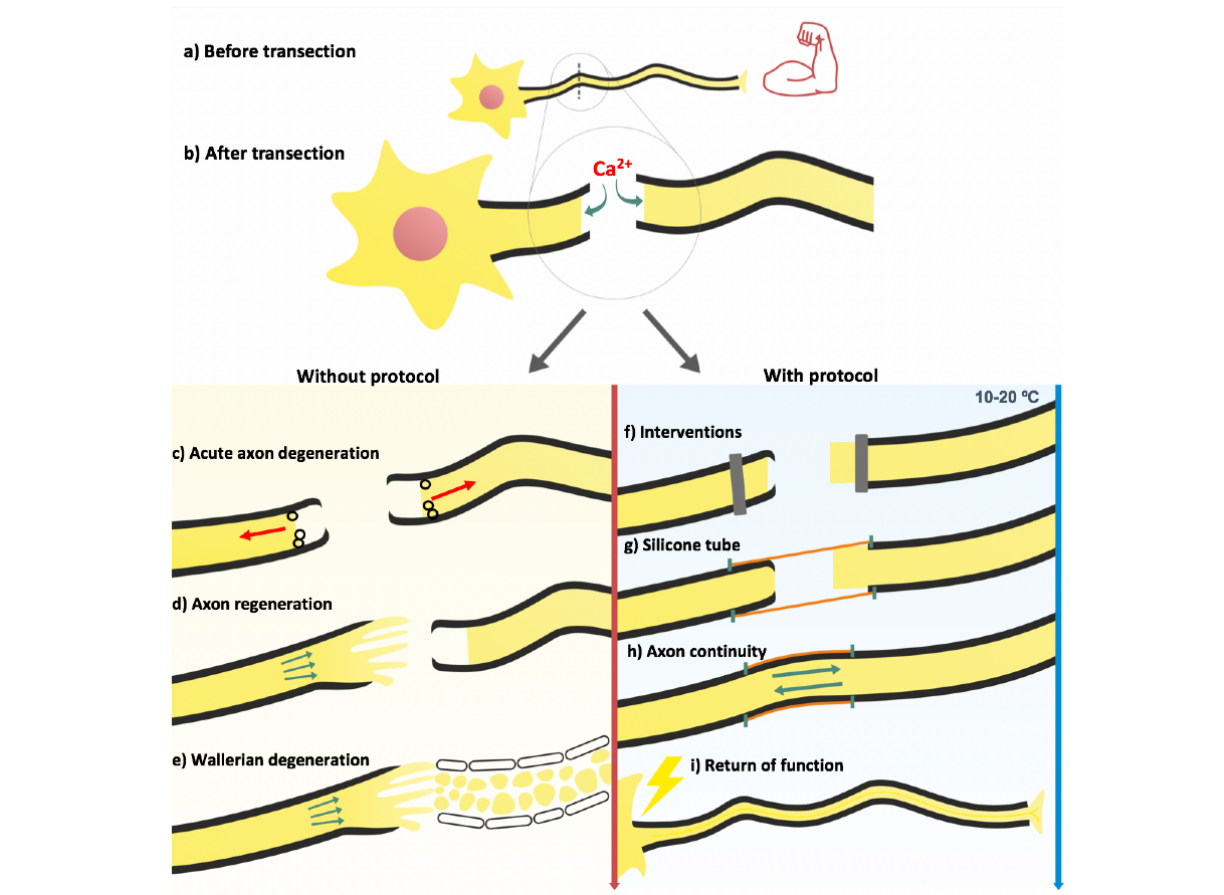
Figure 2. Novel nerve repair protocol. This image compares the usual course of nerve transection (on the left) with the theoretical benefits of the novel nerve repair protocol if fusion occurs (on the right). In (b), note that calcium influx after transection leads to acute axon degeneration, which is noted in (c). Also in (c), membrane seals begin to form (black circles). In (d), axon regeneration begins in the proximal segment. In (e), Wallerian degeneration occurs and regenerating axons regenerate within Schwann cell tubes. In (f), the preoperative interventions have been administered and double approximating clamps (gray vertical lines) are applied to the proximal and distal nerve ends, which will act to seal the axolemmal membranes and prevent further axon degeneration. In (g), the silicone tube is sutured in place after nerve ends have been rinsed with calcium-free saline. If mammals possess the machinery necessary for auto-fusion under the proper conditions, axon continuity could theoretically be restored with return of function, as represented by (h) and